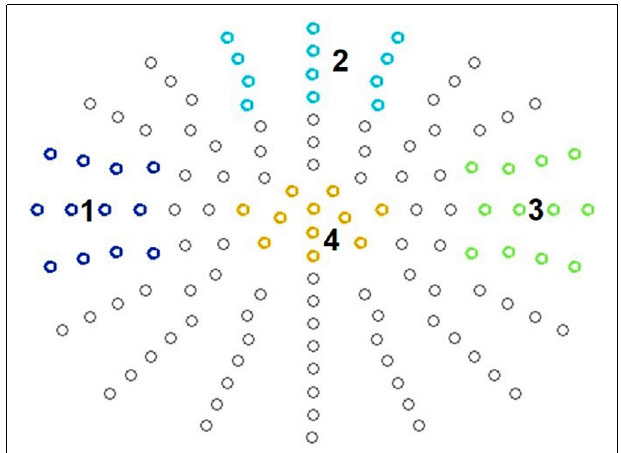
FIGURE 2 | Defined clusters. N140: temporal left (1), frontal cluster (2), and temporal right (3). P300: centro-parietal cluster (4).